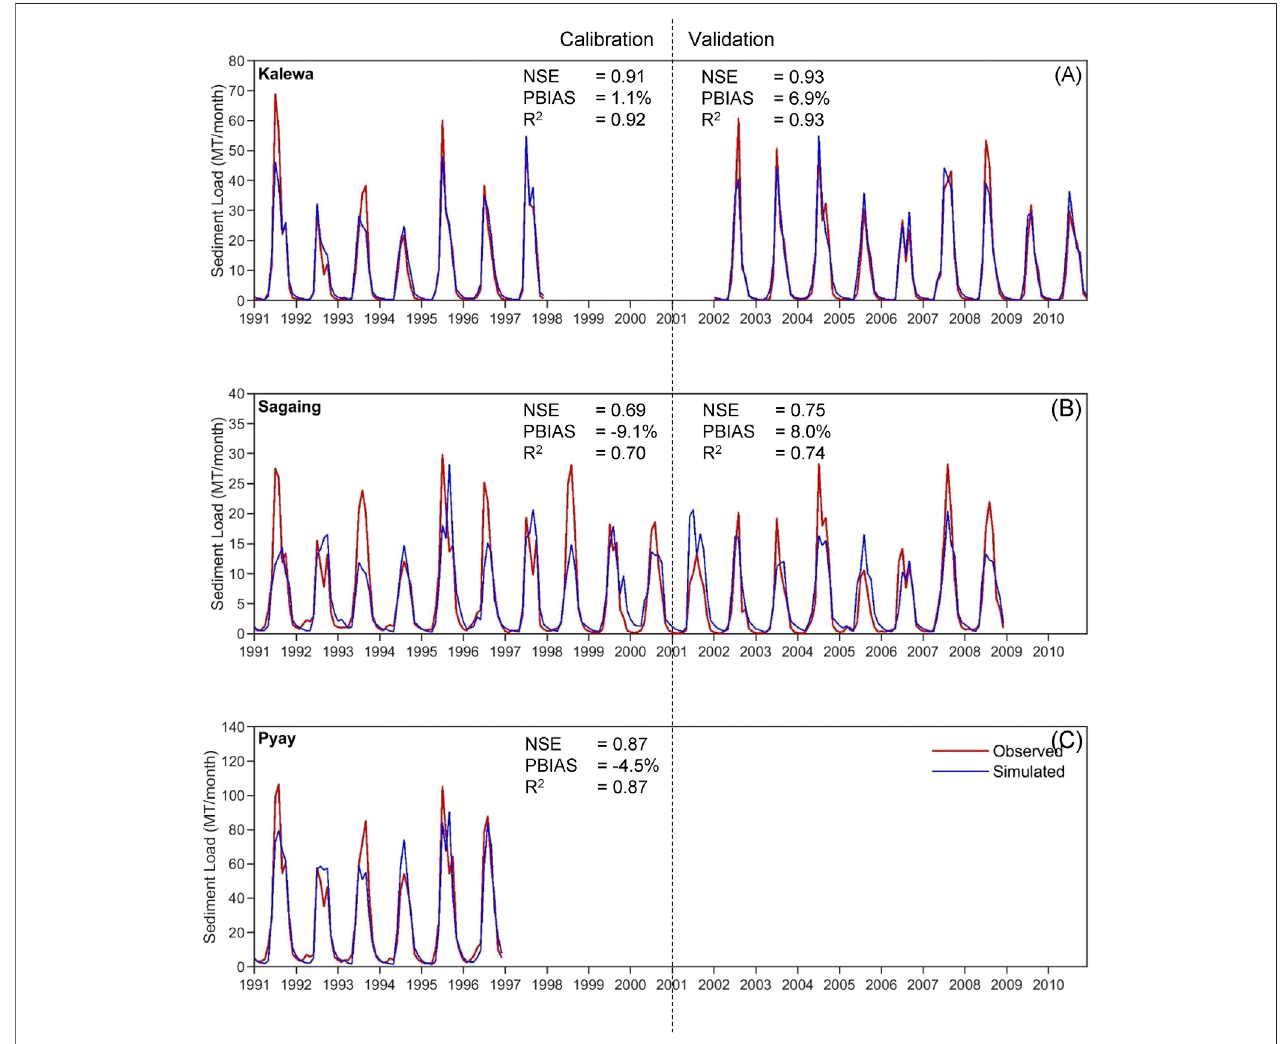
FIGURE 2 | Observed and simulated monthly sediment load at the three gauging stations: Kalewa (A) , Sagaing (B) , and Pyay (C) for the calibration-validation period (1991 – 2010).